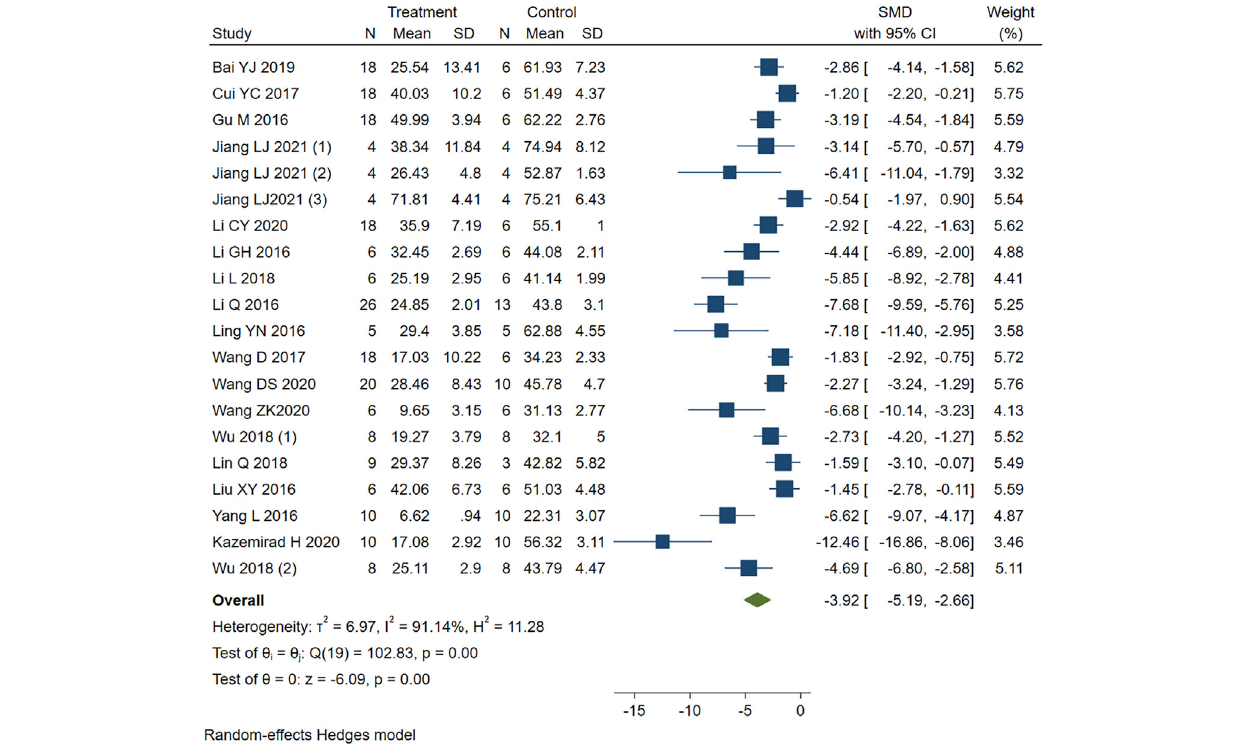
Frontiers in Pharmacology |